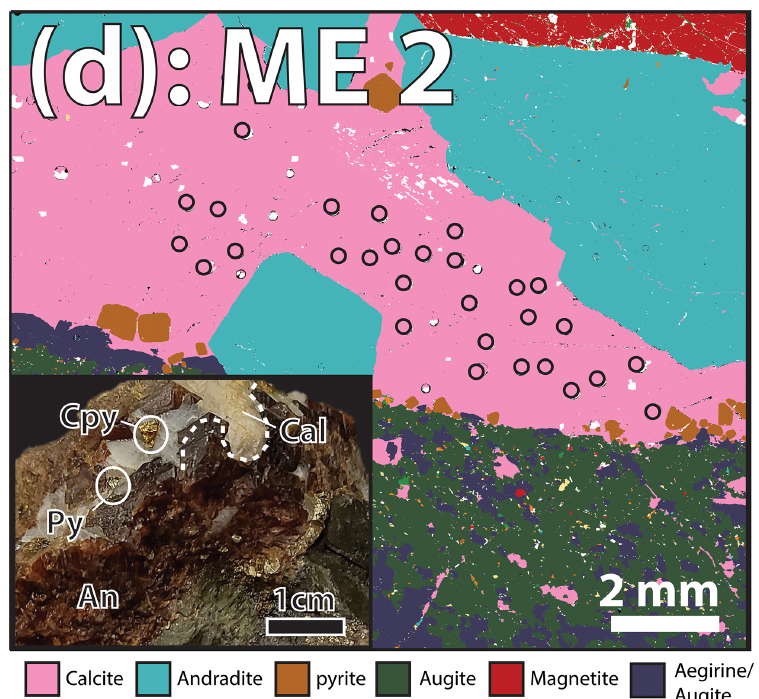
Figure C4. Large image of sample ME 2 from Mt Elliott, Mt Isa region, Australia. Large images shows SEM mineral map with black circles showing laser spot locations. Inset shows hand sample photo. Cpy: chalcopyrite; Py: pyrite; Cal: calcite; An: andradite.